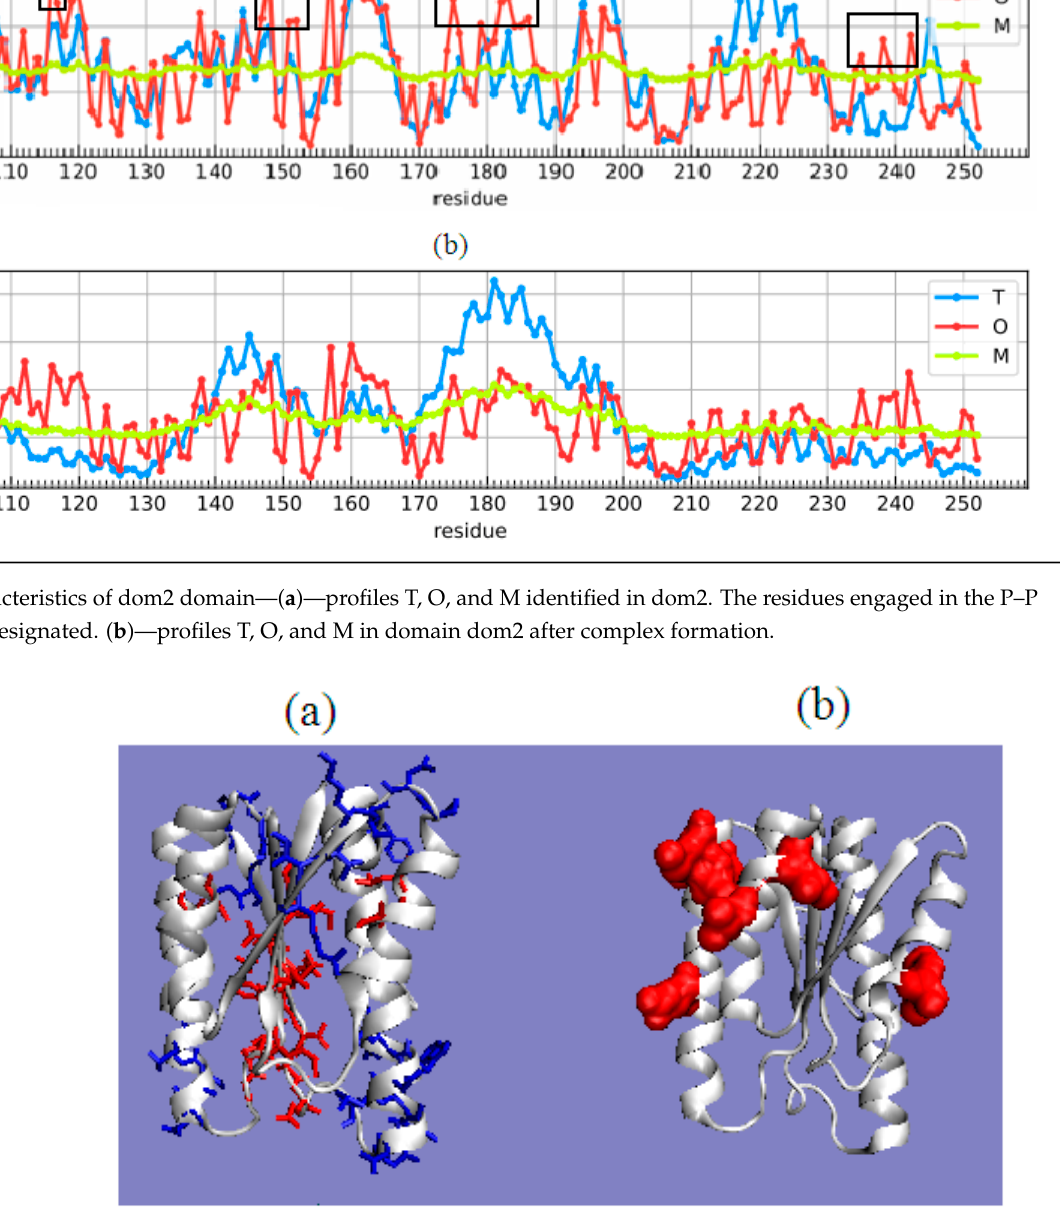
Figure 11. 3D visualization: ( a )—dom2 with the highlighted zones: hydrophobic core—red, surface—blue, ( b )—a structure of dom2 with the highlighted residues (red) representing a local hydrophobicity excess—in a complex engaged in P-P interaction.